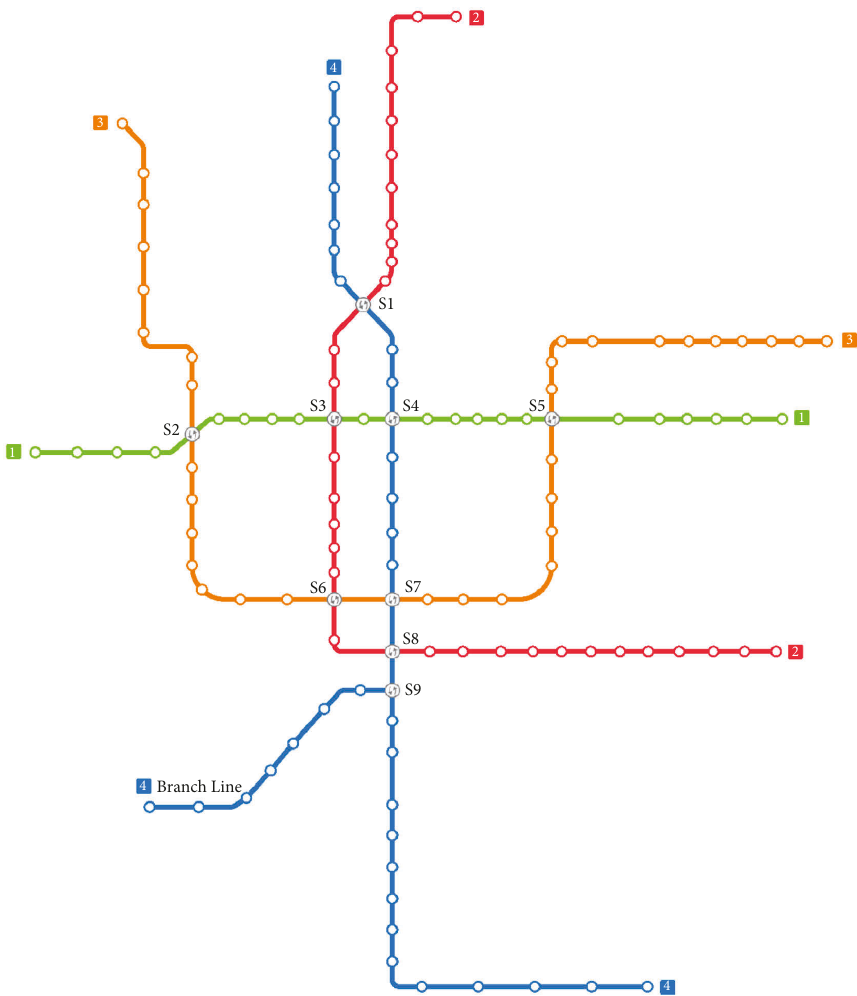
Figure 6: Suzhou URT